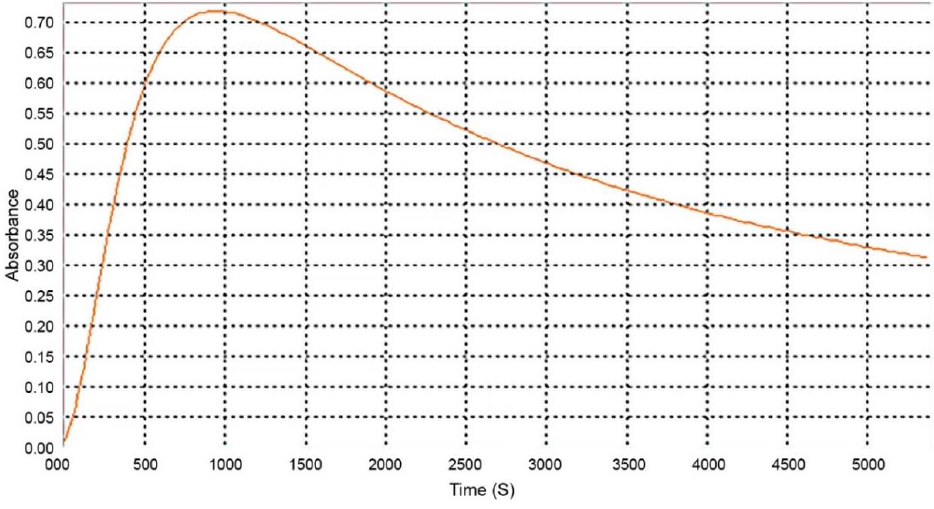
Figure 5. Absorption of the Liebermann – Burchard reagent with cholesterol at 620 nm over